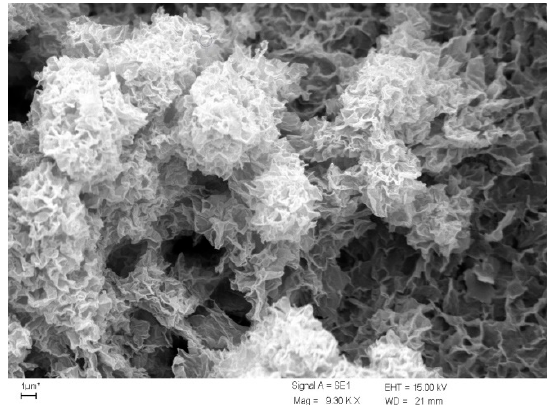
Figure 4. The surface of MnO x coated chalcedonite after removal manganese from water. Reprinted with permission from Ref. [130].